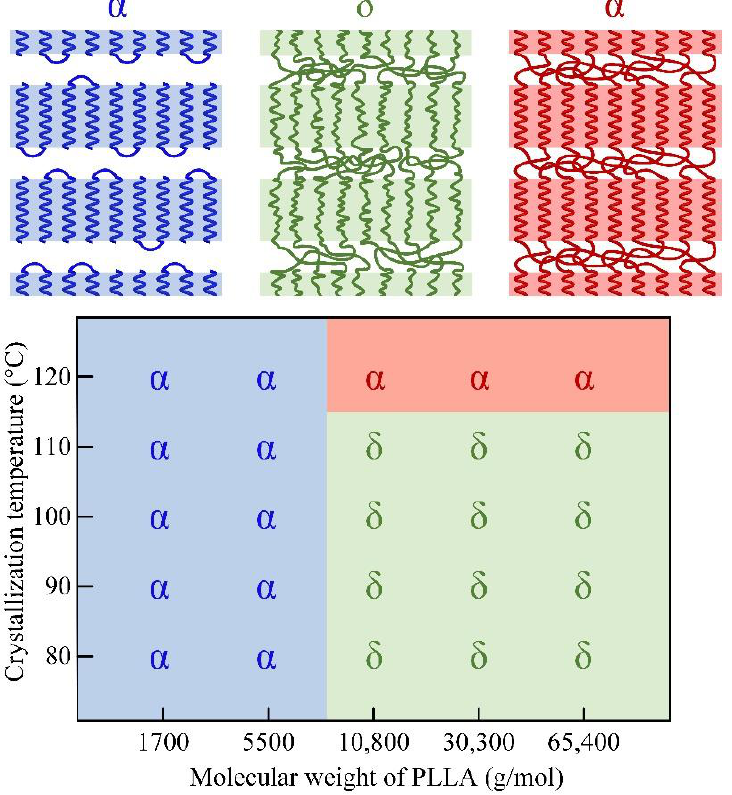
Figure 8. Diagram of crystal forms of PLLA with different molecular weights and different crystal- lization temperatures.